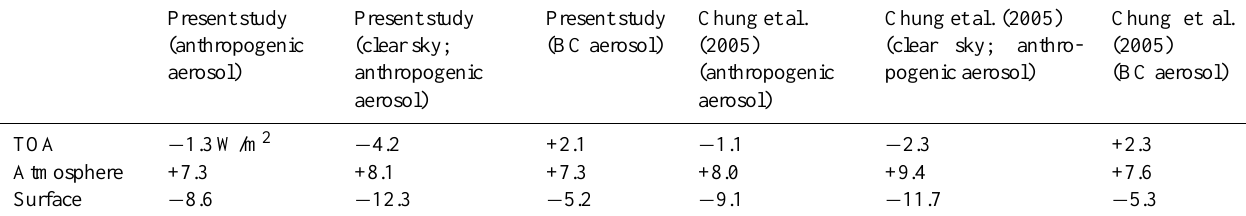
Figure 7. Monthly BC (black carbon) concentration comparison (in units of (cid:181)g/m 3 ). Blue line displays the MAC observation data over 73.18 (cid:176)E & 6.78(cid:176)N during March 2006 ( Ramanathan et al . 2007). Red lines show the present model calculation at a nearby grid (73.36 (cid:176)E & 6.6(cid:176)N) in March 2001, March 2002, March 2003 and March 2004, respectively.